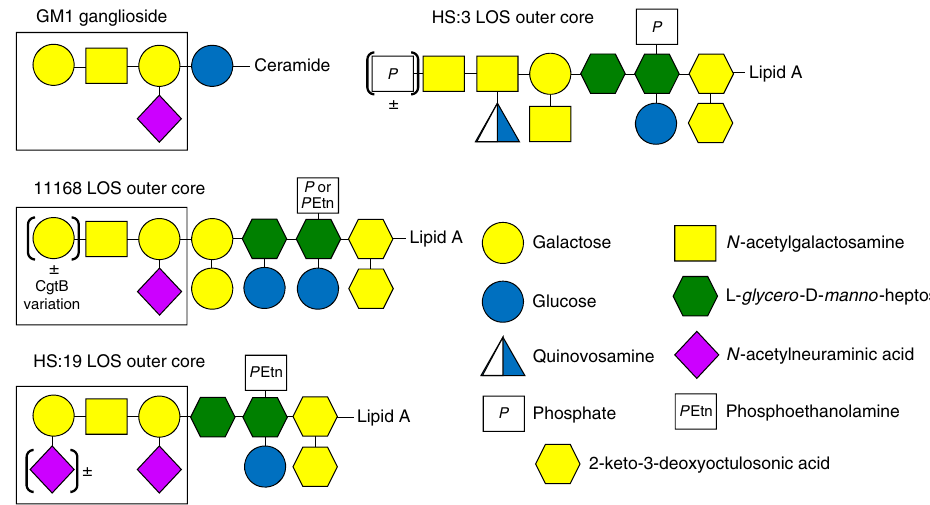
Fig. 1 Structures of GM1 ganglioside and the outer LOS core of the wildtype C. jejuni strains used in this study. The portion of each receptor that is recognized by α -GM1 antibodies and cholera toxin is indicated by the